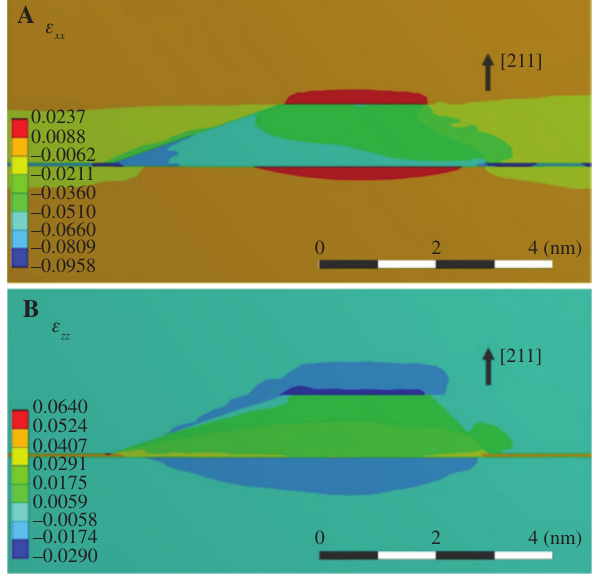
and (B) out-of-plane xx